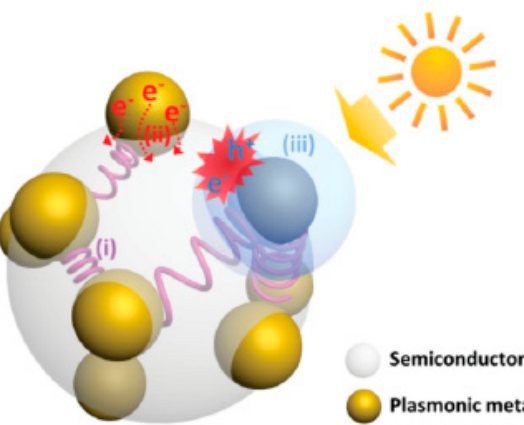
Figure 3. Schematic illustration of three generally accepted mechanisms for plasmonic enhancement: (i) light scattering, (ii) HEI, (iii) PIRET. Reproduced with permission from [18]. Copyright John Wiley and Sons, 2015.